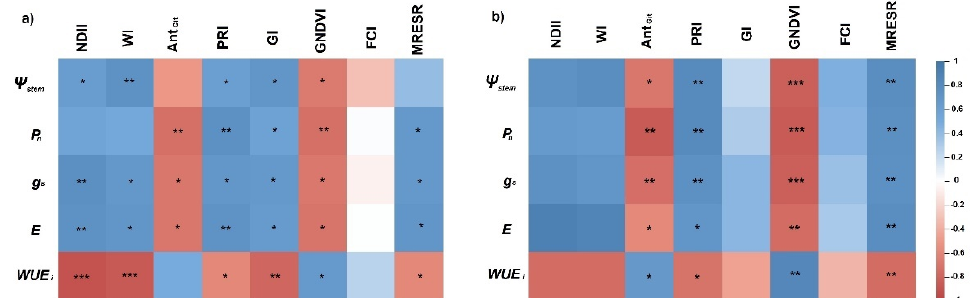
Figure 3. Correlogram between the hyperspectral VIs and the physiological parameters for ( a ) Grenache and ( b ) Shiraz. Positive correlations are displayed in blue and negative correlations in red. Colour intensity is proportional to R (the darker the colour, the higher the coefficient). Single asterisk indicates a significant correlation, p < 0.05; double asterisk indicates a significant correlation, p < 0.01; triple asterisk indicates a significant correlation, p < 0.001.